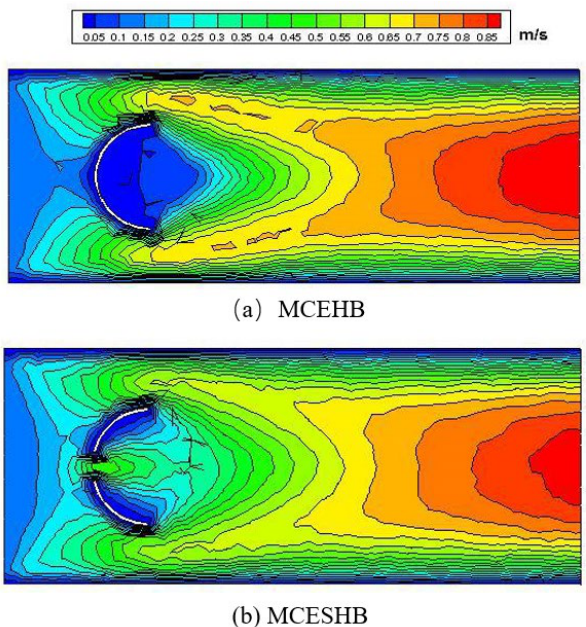
Figure 3. Velocity field distribution of two